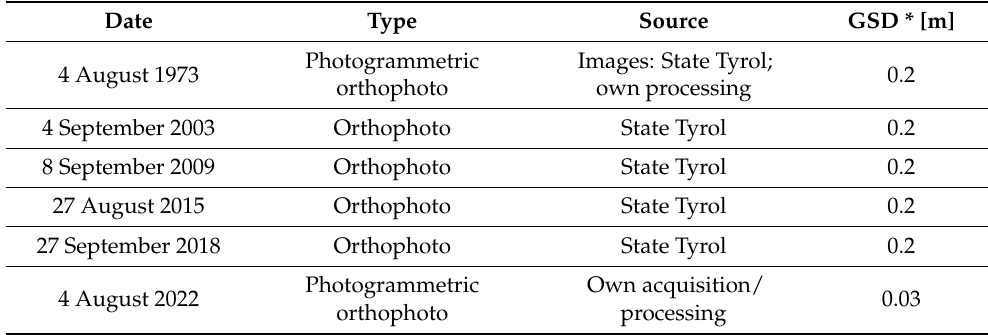
Table 2. Information on the orthophotos used in this